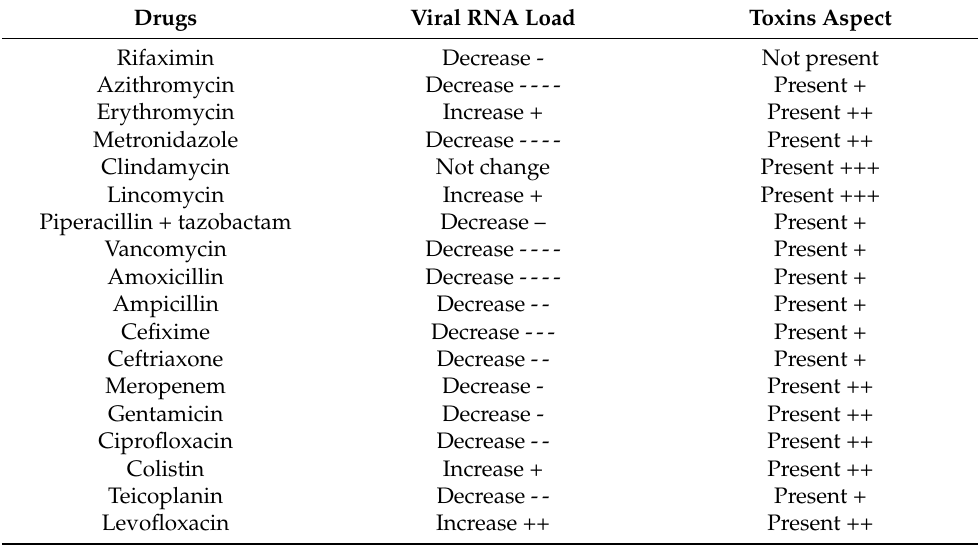
Table 1. Antibiotics are used in bacterial samples. Legend for viral RNA load: + slight increase, ++ marked increase; ---- decrease of viral RNA load 100%; --- decrease of viral RNA load 65–85%, -- decrease of viral RNA load 64–40%, - decrease of viral RNA load 39–25%. Legend for toxin aspect: + Slightly present, ++ moderately present, +++ very present. For more info, see Figure 3 of Petrillo et al.